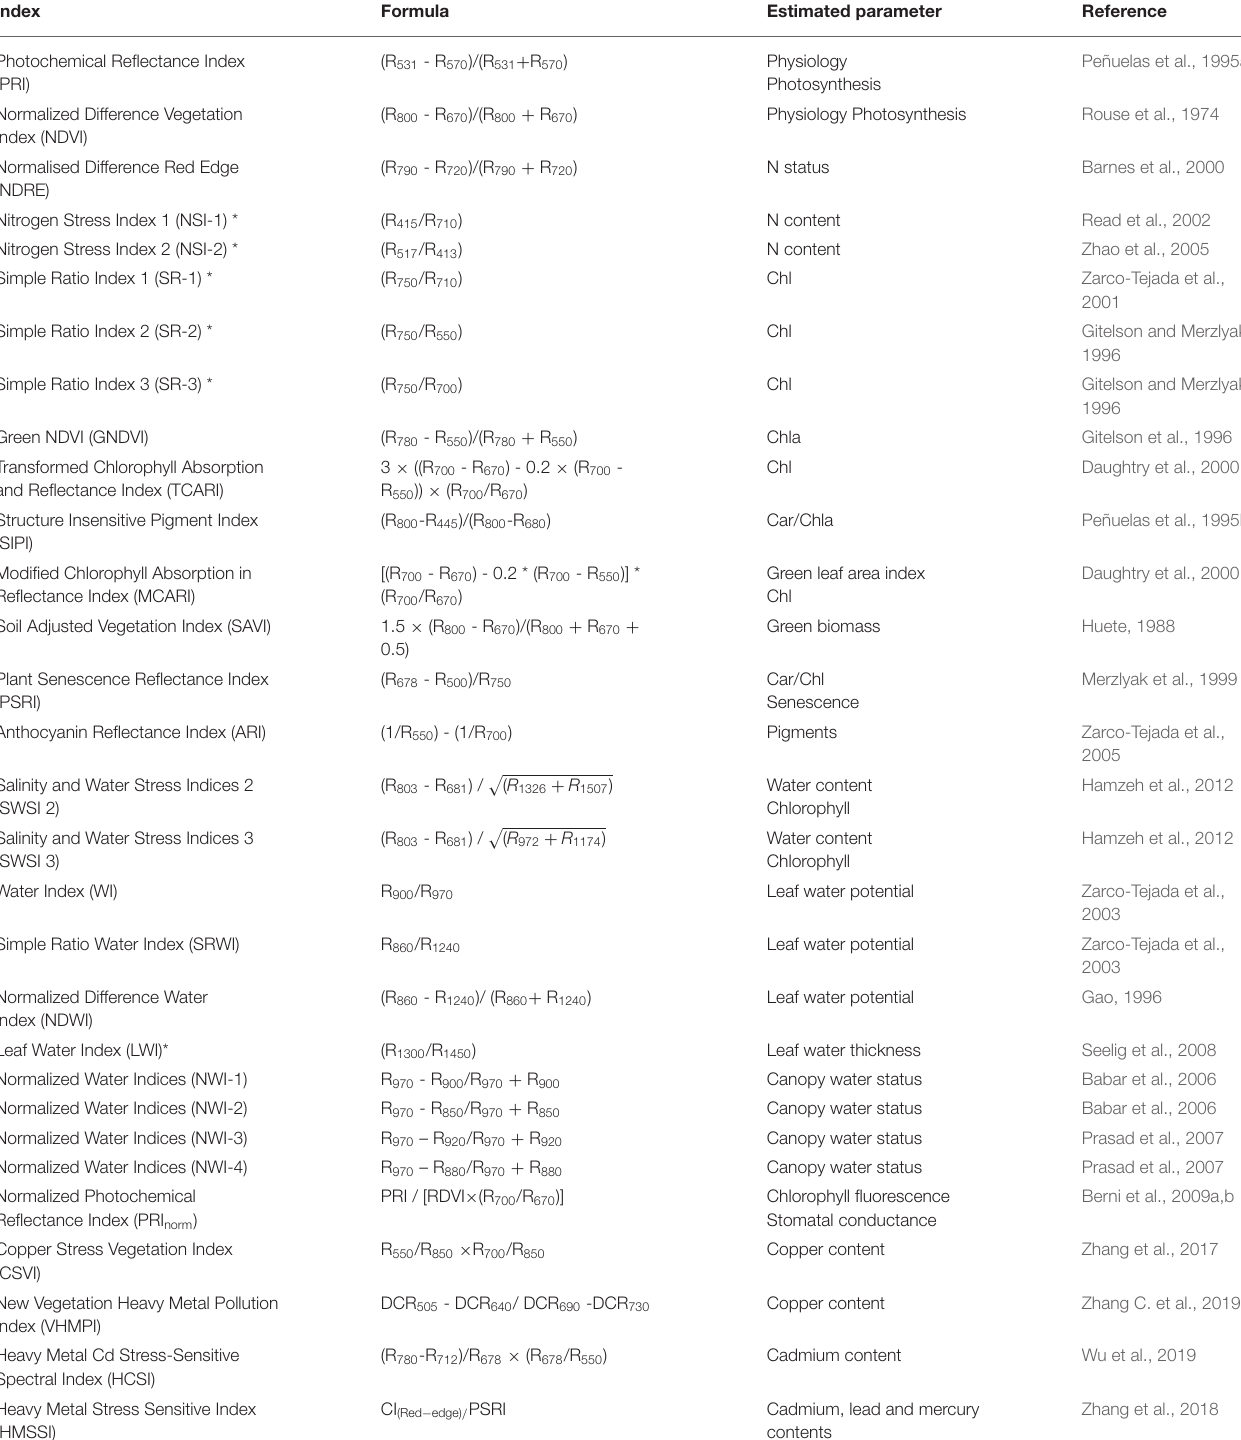
TABLE 1 | Summary of some of the most commonly vegetation spectrum reflectance indices (SRIs) and the related estimated morphological or physiological traits. Traits can relate to more than one stressful condition, so the same index can detect different kinds of stress, both biotic and abiotic. Abbreviations: N, nitrogen; Chl, chlorophyll; Car,